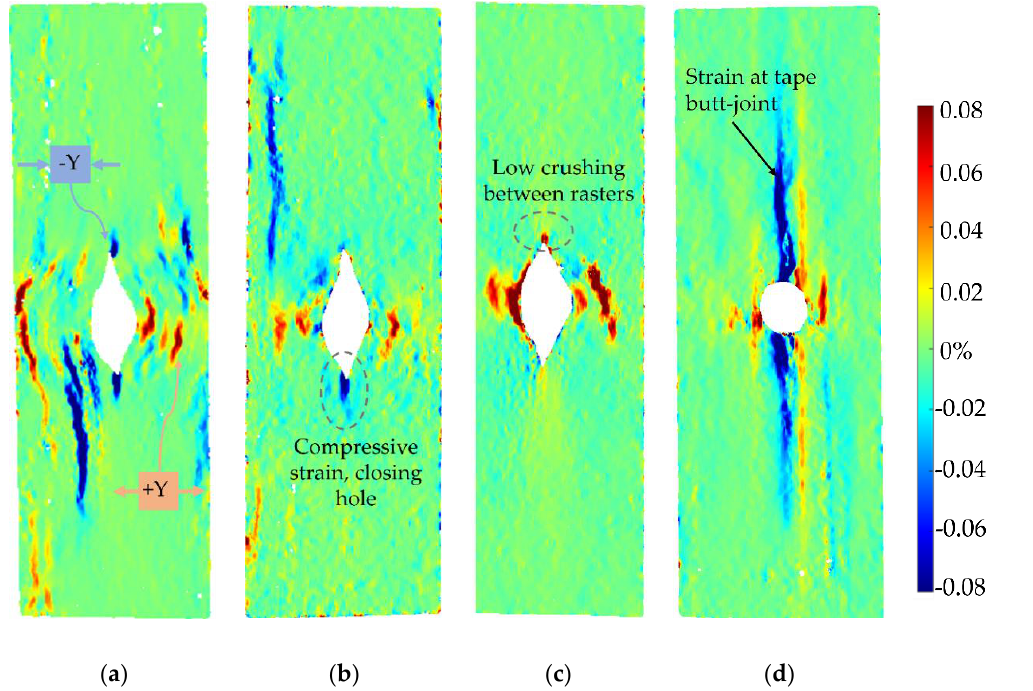
Figure 13. DIC analysis of transverse strain ( ε y ) at the maximum load of each sample in different types: ( a ) printed 10C at 59.77 MPa; ( b ) 4C at 100.5 MPa; ( c ) 4C-Oven at 159.2 MPa (post-printing consolidated part); ( d ) tapes at 166.4 MPa (layup part with a punched hole).